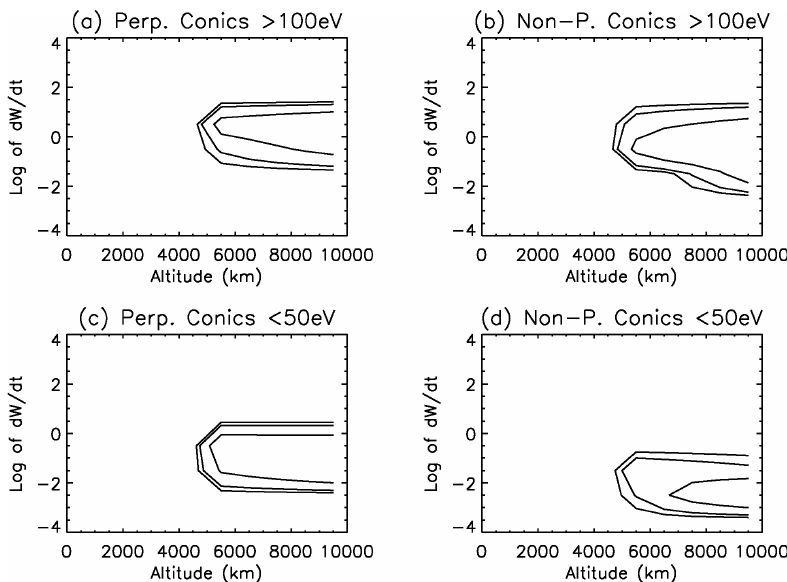
Fig. 9. Contour plots of altitude distribution of heating rate sorted by energy and conic angle (i.e. perp. and non-perp.) of ions, which represents the counterpart of the right panels of Figs. 6 and 7. Lower cutoff at 5000km of altitude is imposed for consistency with actual observations and is not